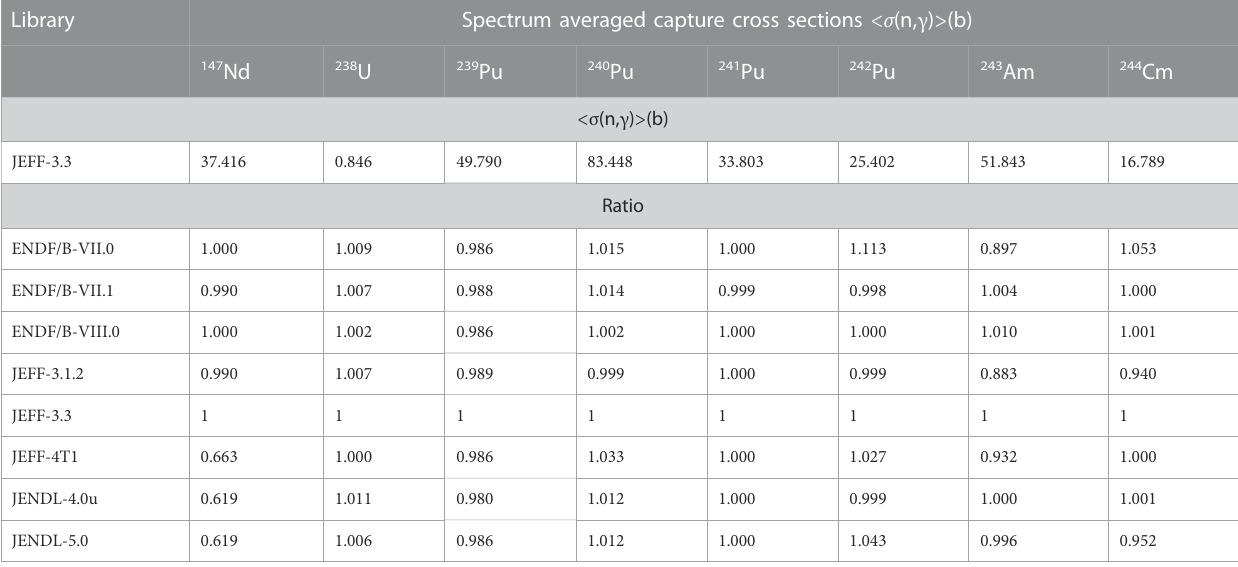
TABLE5Spectrumaveragedcapturecrosssections < σ (n, γ ) > for 147 Nd, 238 U, 239,240,241,242 Pu, 243 Amand 244 Cmderivedfromthe σ (n, γ )crosssectionsadoptedindifferent libraries. The values derived from the JEFF-3.3 library are given together with the values derived from other libraries relative to those of JEFF-3.3. Library